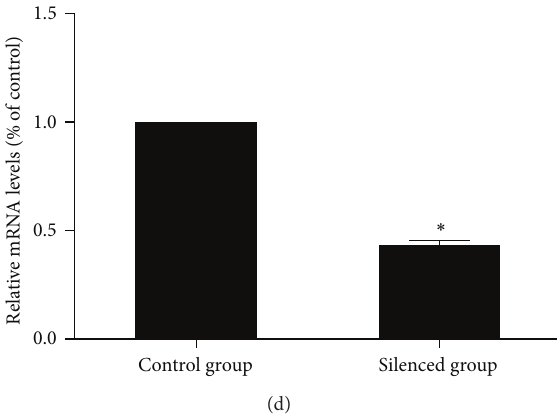
Figure 2: (a) Target site screening for CHI3L1 by western blot analysis and real-time RT-PCR in RAW264.7 cells. The RAW264.7 cell line was transfected with lentivirus expressing different CHI3L1 siRNAs, and gene silencing analysis showed that site C lentivirus was the most effective vector in blocking CHI3L1 expression. (b) The immunohistochemical staining of CHI3L1 and electron microscopy in control group and silenced group. In the control group CHI3L1 expression (arrow) could be demonstrated according to the immunohistochemical staining. However, little CHI3L1 was expressed in silenced group. For electron microscopy, in control group most of the endothelial cells denudated and there were a large number of lipid granules (LG) under the basement membrane (BM) in the vessel wall. The atherosclerotic plaques were occupied with necrotic particles (NP), calcification crystals (CC), and cellular debrises. However, in silenced group the number of lipid granules was relatively decreased. (scale bars = 100 𝜇 m) (c) Western blot analysis and quantification of CHI3L1 protein expression in control group and silenced group. The levels of CHI3L1 protein expression were higher in control group than in silenced group. (d) Real-time RT-PCR quantification of CHI3L1 mRNA expression in control group and silenced group. ∗ 𝑃 < 0.05 versus control